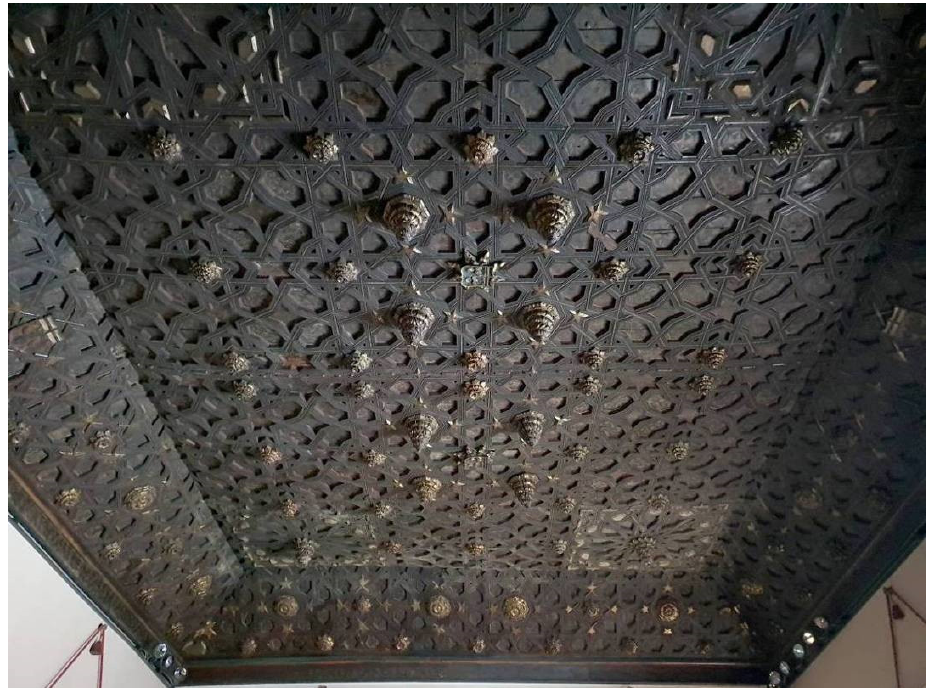
Figure 3. Mezzanine ceiling. Authors’ own photograph, 2020.